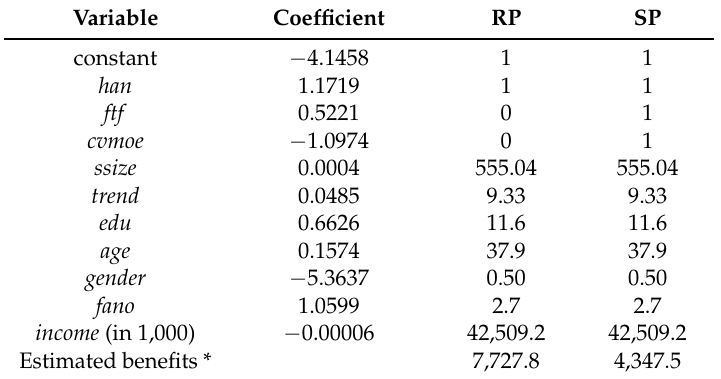
Table 5. The result of benefit calculations based on revealed preference and stated preference